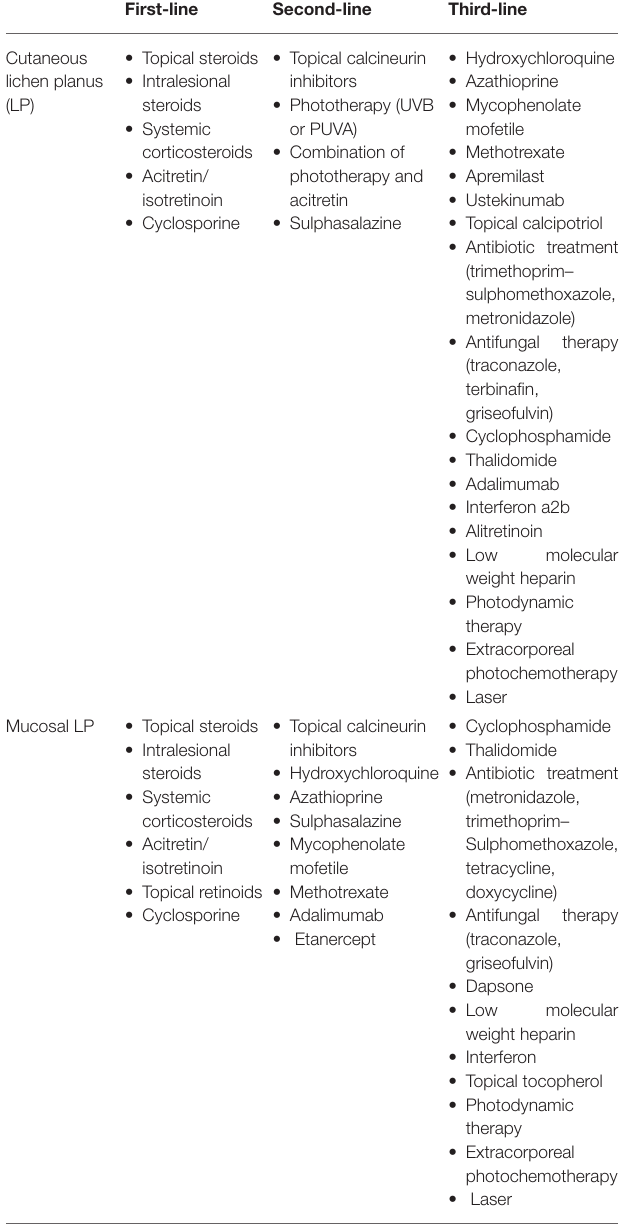
TABLE 3 | Management of lichen